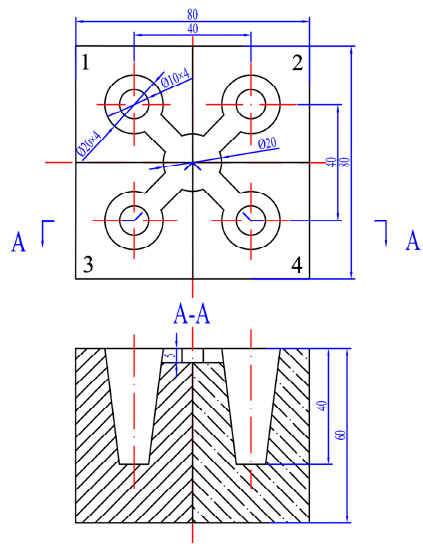
Figure 1. The geometry of the casting model: ( 1 ) graphite; ( 2 ) copper; ( 3 ) steel; ( 4 ) sand. (Unit: mm).